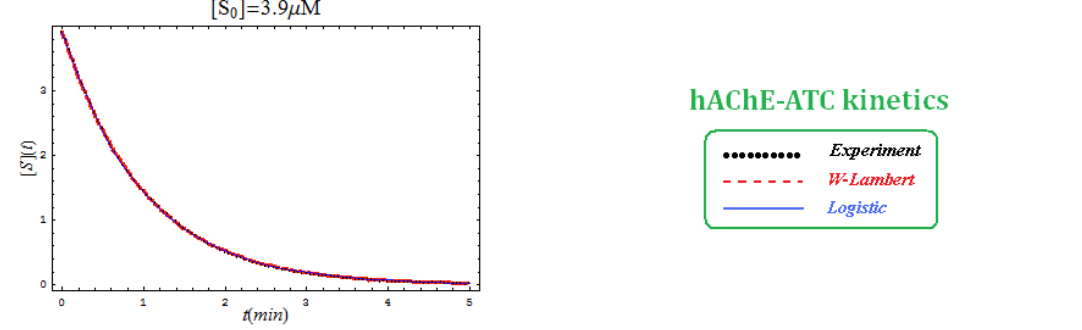
Figure 3. The W-Lambert and logistic progress curves as they fit with experimental data for the hAChE-ATC kinetics, according to the equations (55) and (57), through considering the kinetic parameters from (36) and (39) with the actual values K 8,700 µM; V = 162.45 µM/min; b = 0.12, for various initial substrate max